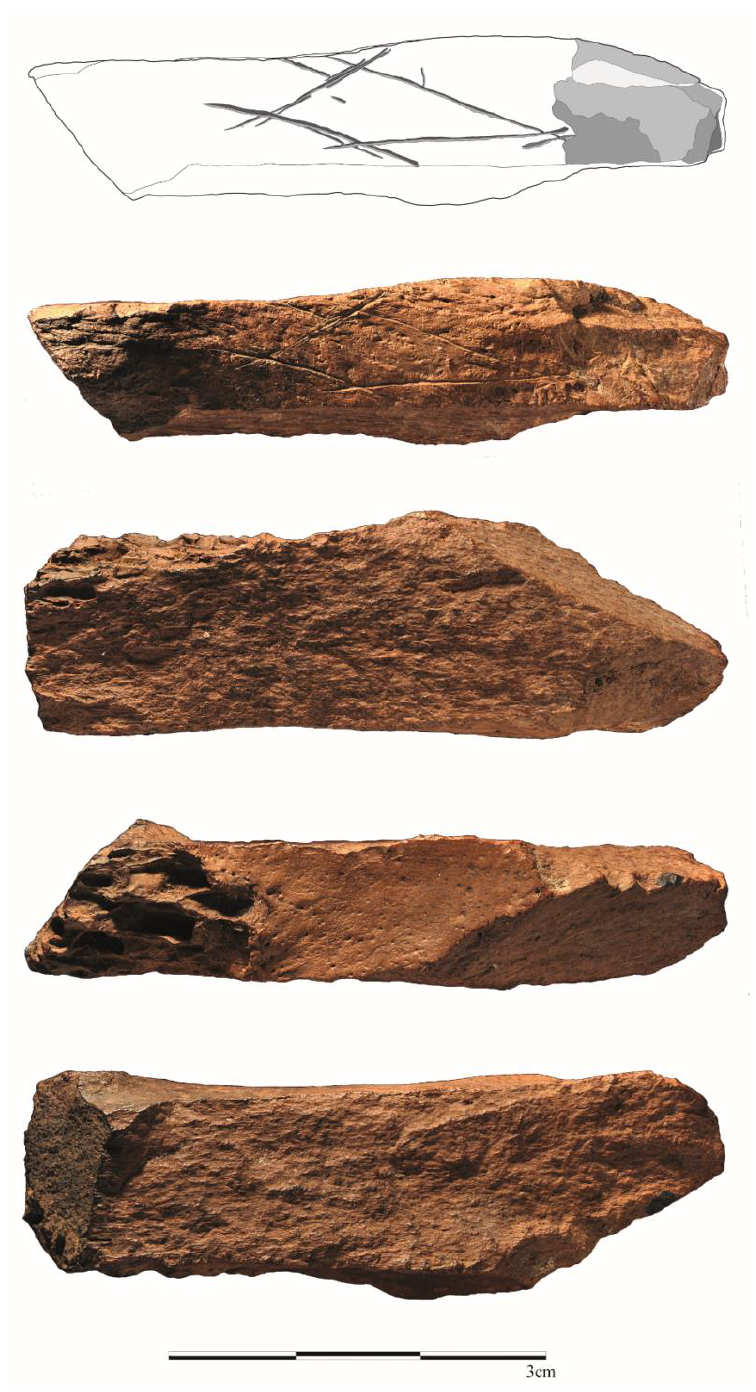
Figure 3 . Different views of the engraved bone from the stratigraphic unit Lynn at Diepkloof Rock Shelter with a diacritic drawing of the engraved cortical surface. A high resolution version of this figure is available at https://doi.org/10.5281/zenodo.5699916. The distinction between intentional and non-intentional incisions rests on the combination of several criteria from macro- to micro-scale (e.g. Domínguez-Rodrigo et al., 2009; Maté-Gonzàles et al., 2015; Monnier & Bischoff, 2014; Olsen & Shipman, 1988; Palomeque-Gonzàles et al., 2017; Soulier & Morin, 2016). The anatomical location of the incisions, their orientation and distribution on the bone, as well as their length and cross-section are all relevant features to distinguish deliberate engravings from accidental butchery marks, including retouching scores. At a higher magnification, evidence of reiterated passages